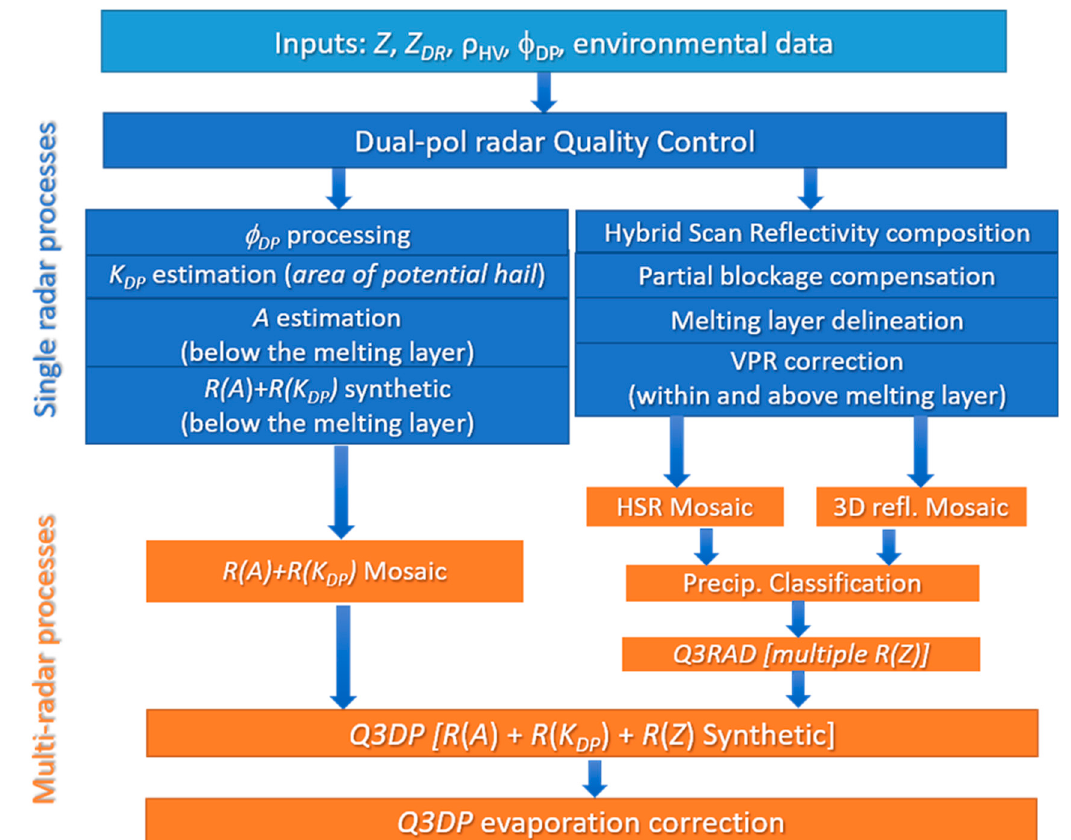
Figure 19. An overview flowchart of the MRMS DP radar synthetic QPE.